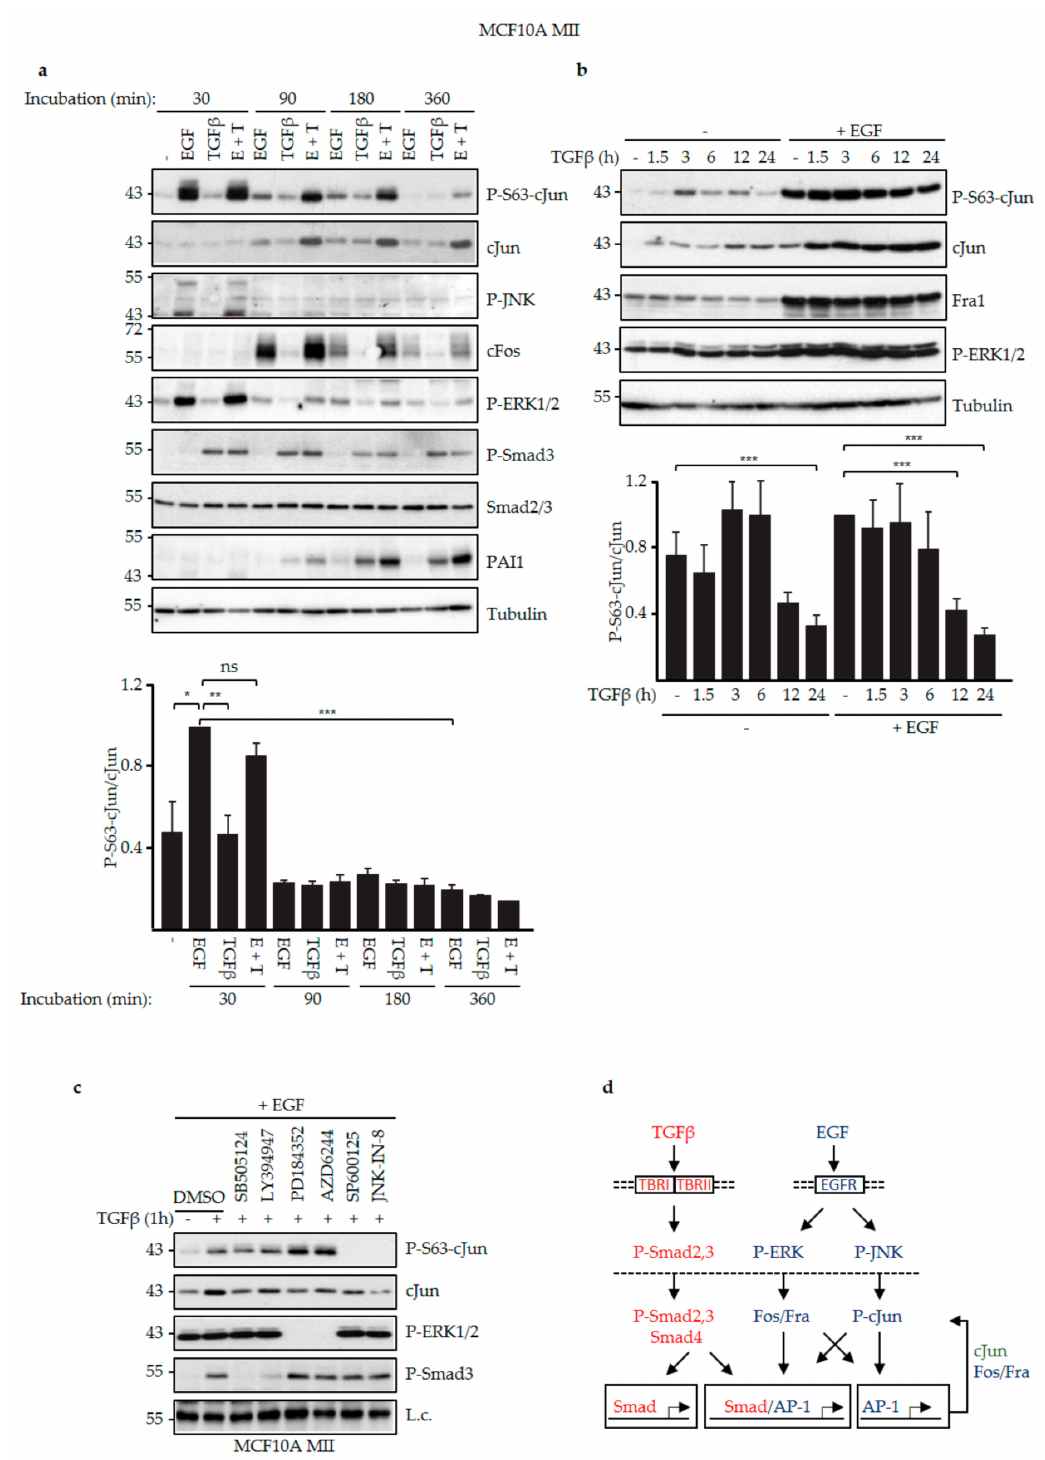
Figure 3. EGF and TGF β di ff erentially induced phospho-cJun activity. ( a ) MCF10A MII cells were incubated for 24 h in serum-starvation medium (insulin, cholera toxin, hydrocortisone, 0.2% FBS) without EGF, subsequently treated with 20 ng / mL EGF and / or 5 ng / mL TGF β for the indicated time periods, and then analyzed by immunoblotting for P-S63-cJun, cJun, P-JNK, cFos, P-ERK1 / 2, P-Smad3, Smad2 / 3, and PAI1. Tubulin was included as loading control; a representative experiment is